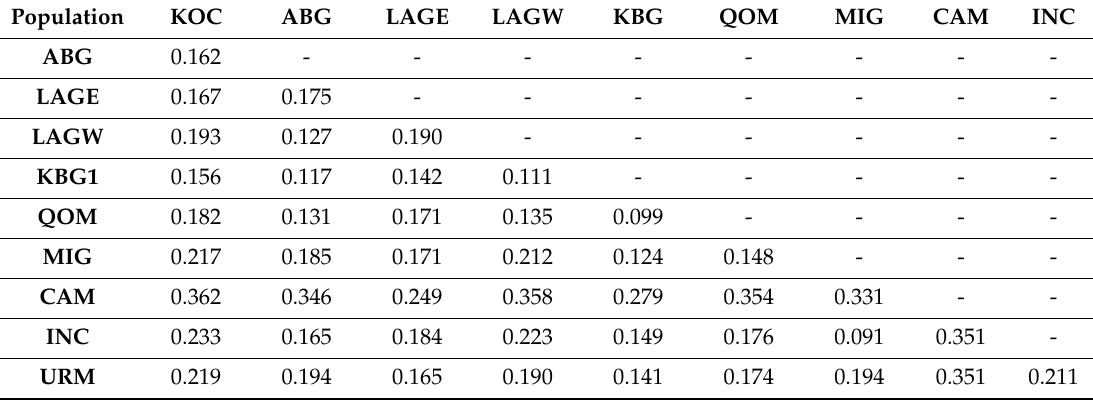
Table 7. Pairwise Population Matrix of Nei Genetic Distance among invasive A. franciscana populations. Population